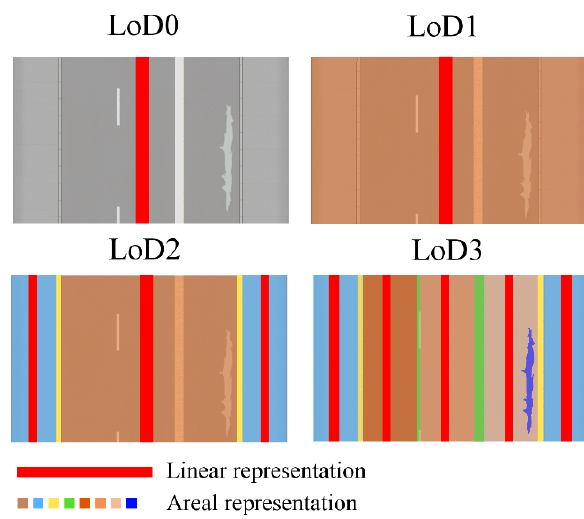
Figure 4. Linear and areal representations in LoD0-3